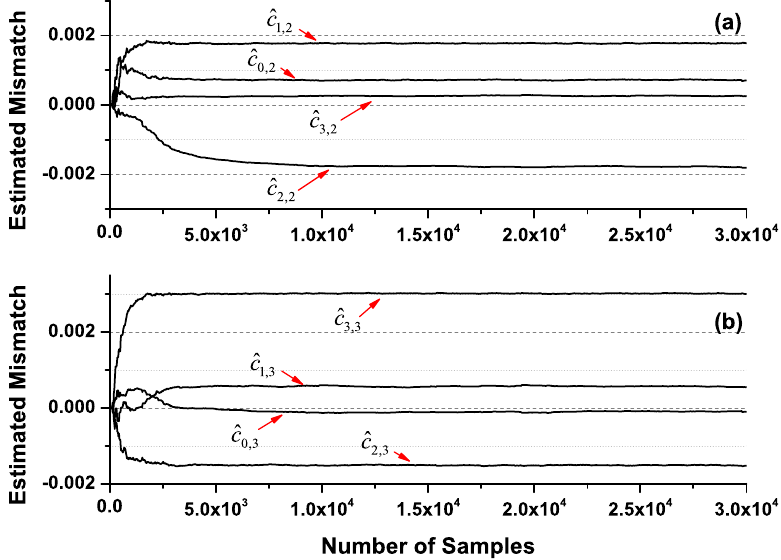
Figure 11. The convergence behavior of the estimated parameters ˆ c k , l [ n ] for dual band noise input.